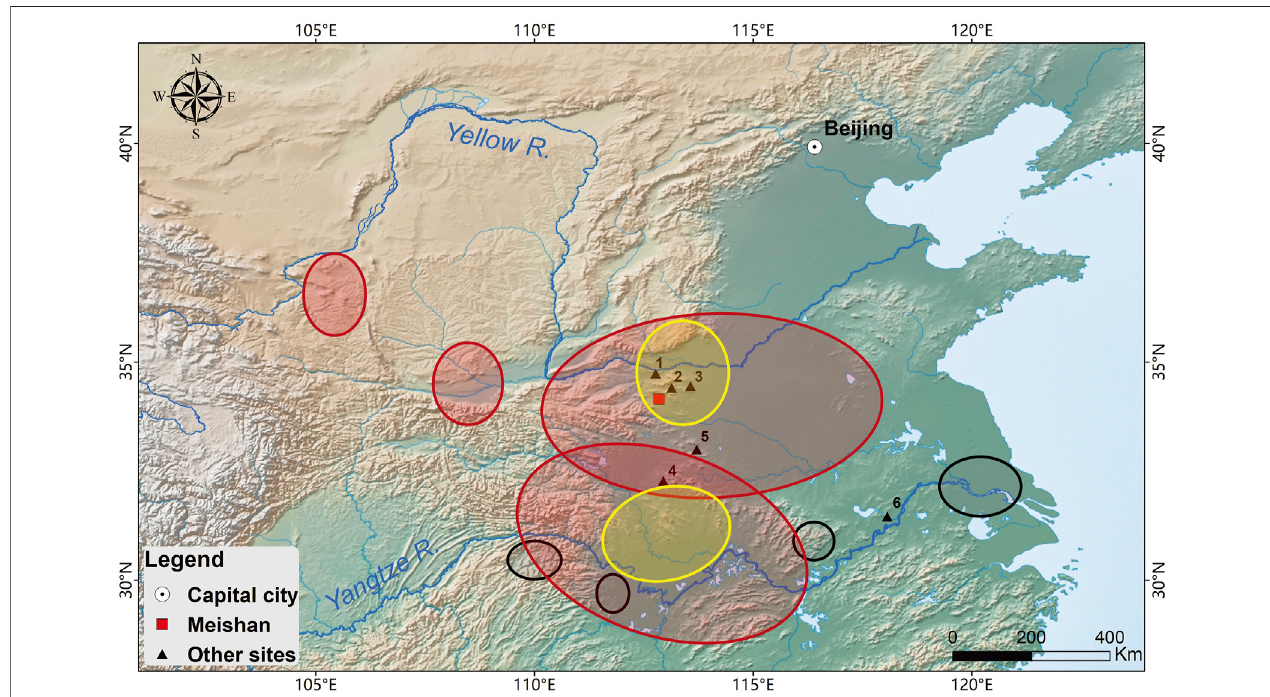
FIGURE 1 | Spatiotemporal distribution of grooved potteryvessels and location of the Meishan site and other archaeological sites mentioned in the text. Shadows with black circles indicate the initial area where the grooved pottery vessels appeared during the early phase of the Songze culture, shadows with yellow circles indicate thescenarioduringthemid-Songze culture,and shadowswithredcircles indicatethescenario ataround4,000 yearsago.1,YanshiShangcheng; 2,Wangchenggang; 3, Xinzhai; 4, Diaolongbei; 5, Yangzhuang; 6, Lingjiatan. The base map was obtained from the Natural Earth public domain map dataset (https://www.